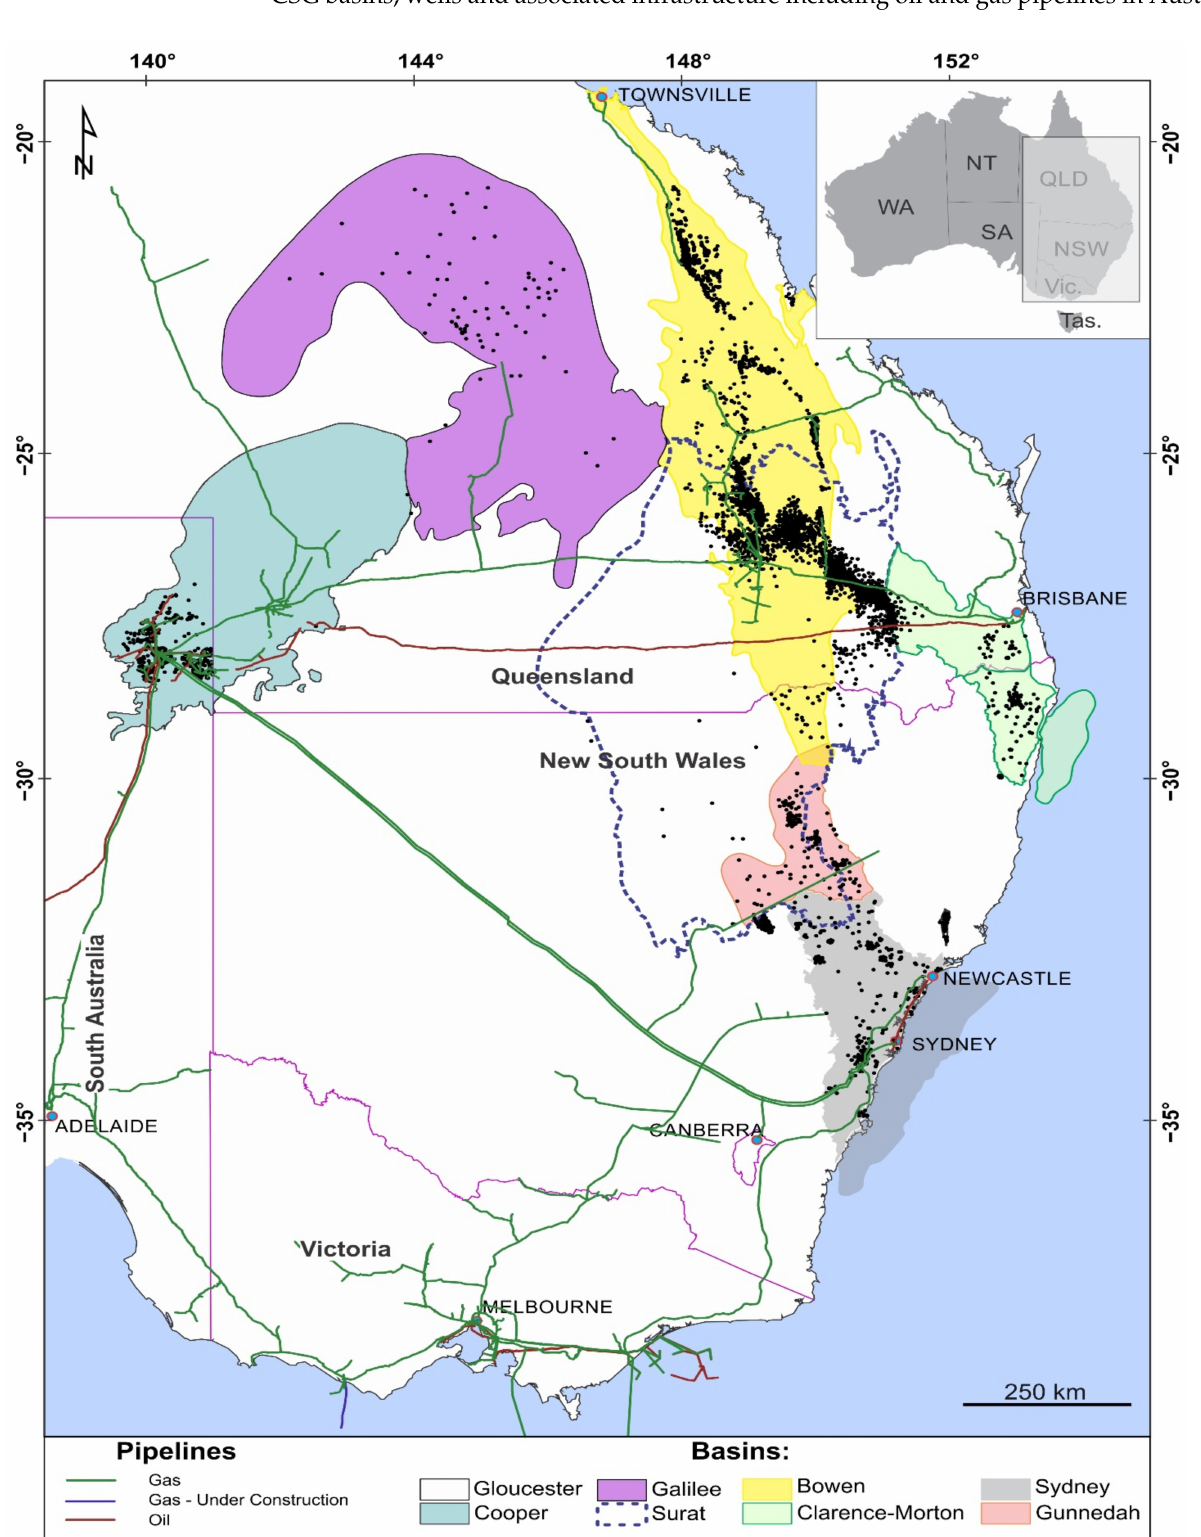
Figure 1. Location of major coal seam gas basins in eastern Australia. Wellbores (black dots) and associated infrastructure including oil and gas pipelines are also